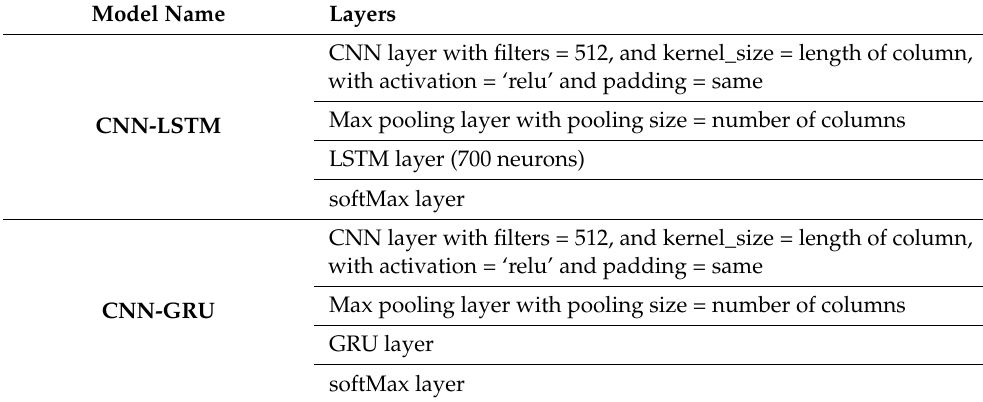
Table 1. Different DL model architectures. Model